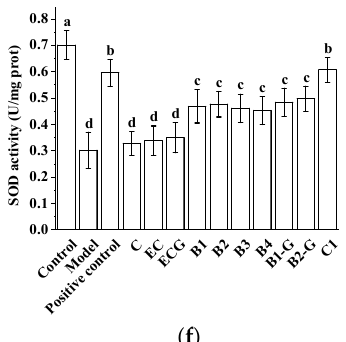
Figure 3. Effects of procyanidins with different structures on oxidative stress in PC12 cells treated with H 2 O 2 . ( a ) Representative fluorescence photomicrographs of PC12 cells; ( b ) ROS levels; ( c ) MDA levels; ( d ) GSH-Px activity; ( e ) CAT activity; ( f ) SOD activity. Data are expressed as the mean ± SD. Control, Blank control group; Model, H 2 O 2 (200 µ M); Positive control, NAC (20 µ M) + H 2 O 2 (200 µ M); C, C (5 µ M) + H 2 O 2 (200 µ M); EC, EC (5 µ M) + H 2 O 2 (200 µ M); ECG, ECG (5 µ M) + H 2 O 2 (200 µ